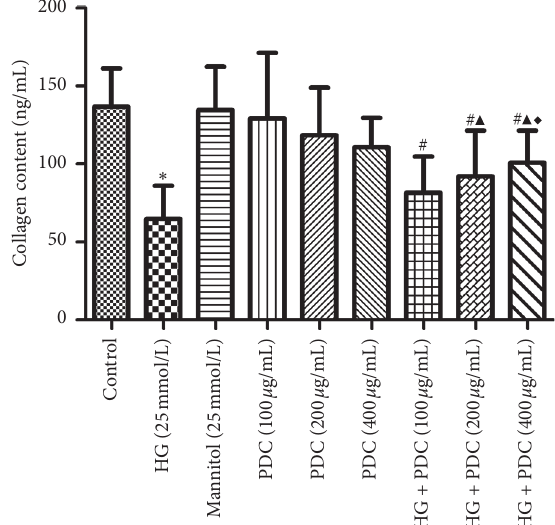
Figure 3: Effect of high glucose concentration and PDC on the collagen content in the cell culture fluid. HSF cells were incubated at high glucose concentration (25 mmol/L) or PDC (100, 200, and 400 μ g/mL) for 48h. The cell culture fluid was collected, and the level of collagen in the culture fluid was detected by a kit method. All the data were expressed as x ± S ( n � 3). ∗ P < 0 . 05, compared with the control group; # P < 0 . 05, compared with the high-glucose group; ▲ P < 0 . 05, compared with the high-glucose+ Dendrobium polysaccharide (100 μ g/mL) group; ◆ P < 0 . 05, compared with the high-glucose + Dendrobium polysaccharide (200 μ g/mL) group.